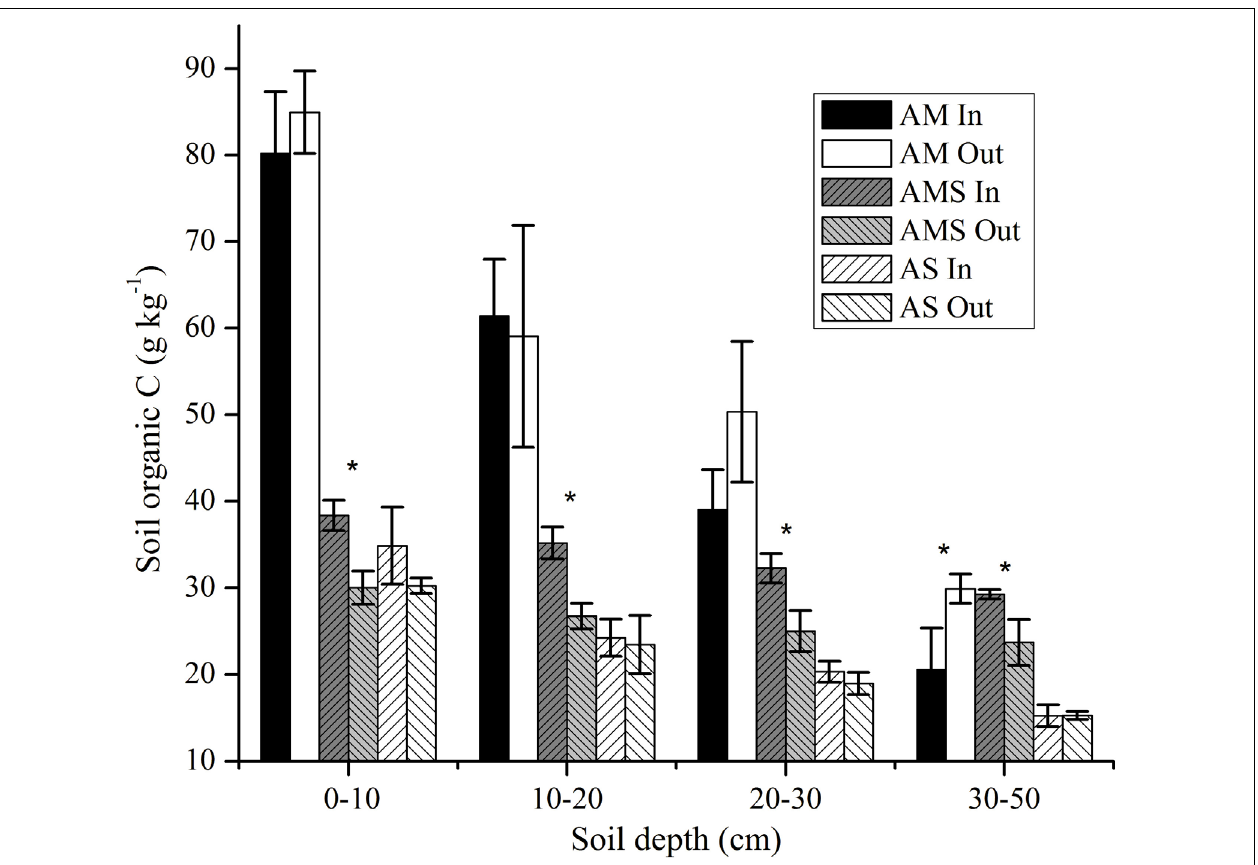
FIGURE 4 | Soil organic C in the vertical direction between enclosed (In) and grazed (Out) sites with three vegetation types: alpine meadow (AM), alpine meadow steppe (AMS), and alpine steppe (AS). Error bars were the standard error of three replicates soil organic C between enclosed and grazed sites. *Mean the change of SOC difference was significant at P <